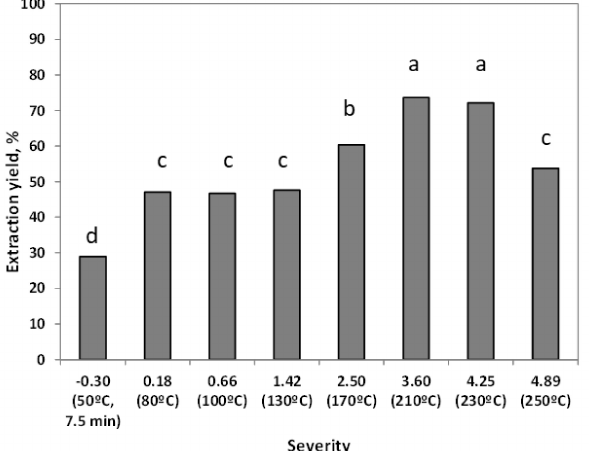
Figure 2. E ff ect of severity on the solid extraction yield. Error bars were lower than the symbol size. Letters represents the statistical